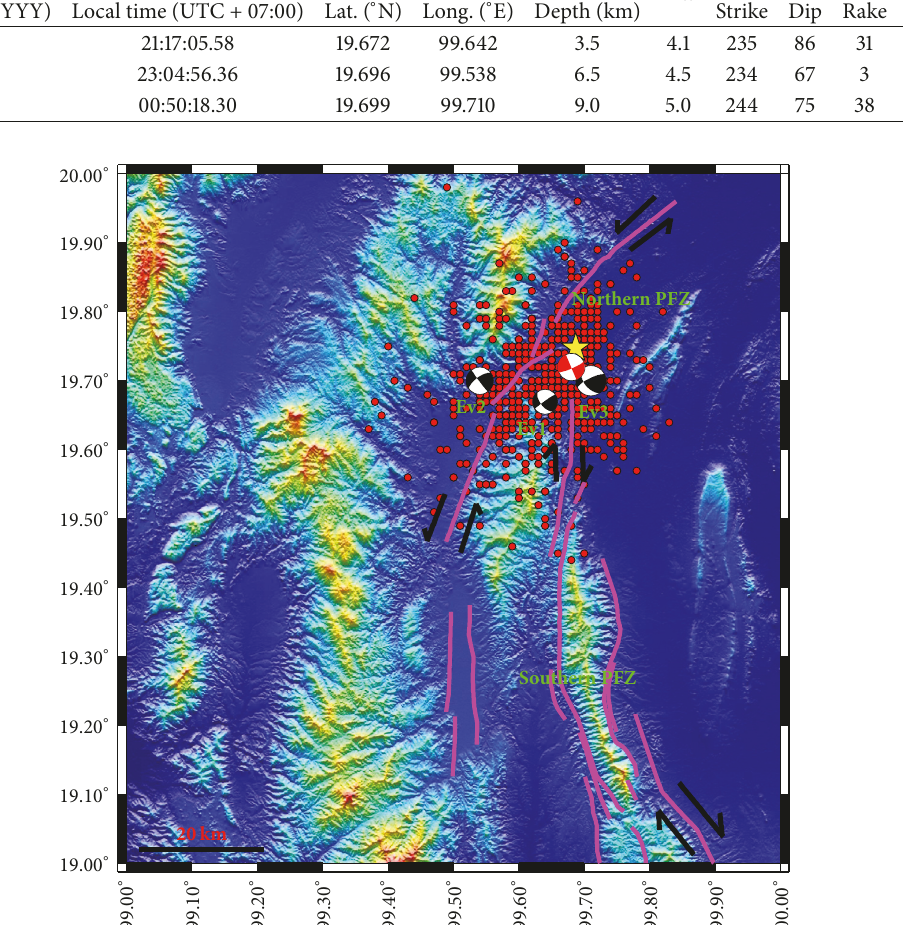
Table 2: Results from the DMT inversion are drawn as black beach balls in Figure 2. Ev.